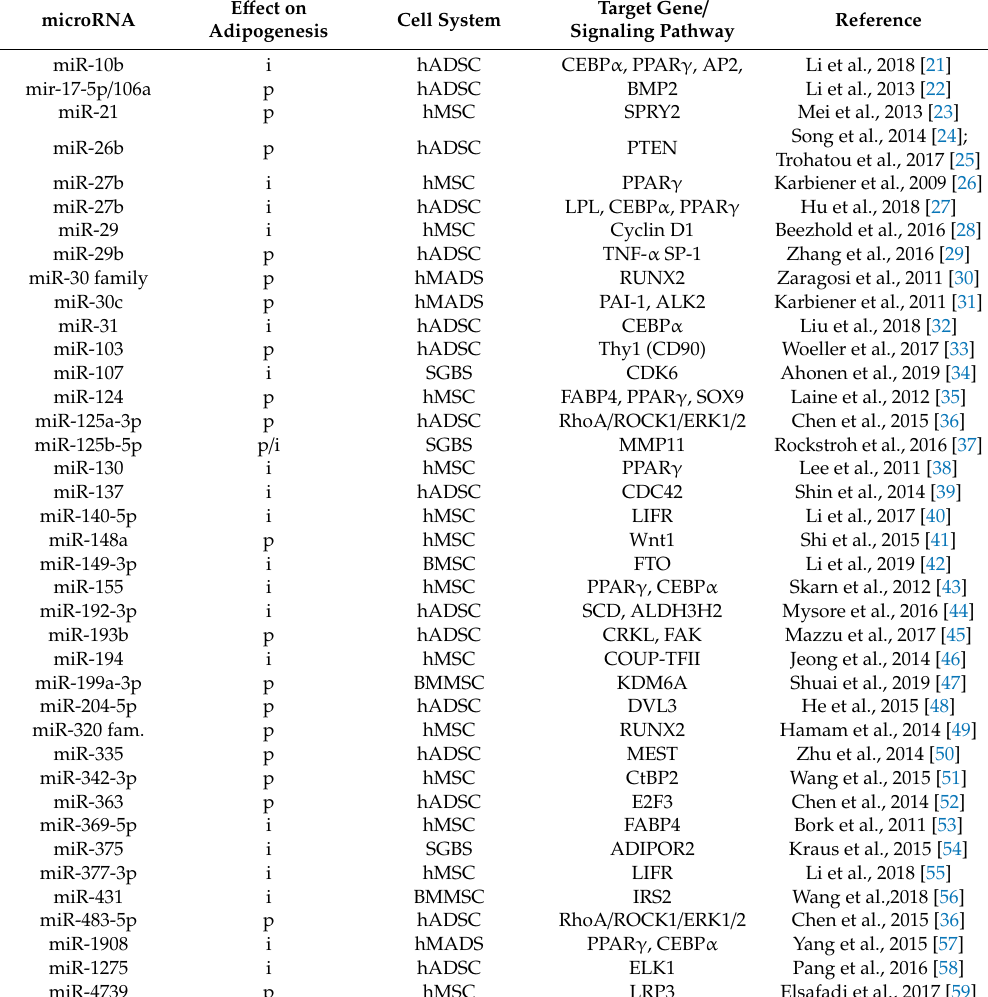
Table 1. Adipogenesis-regulating microRNAs in human cell lines /